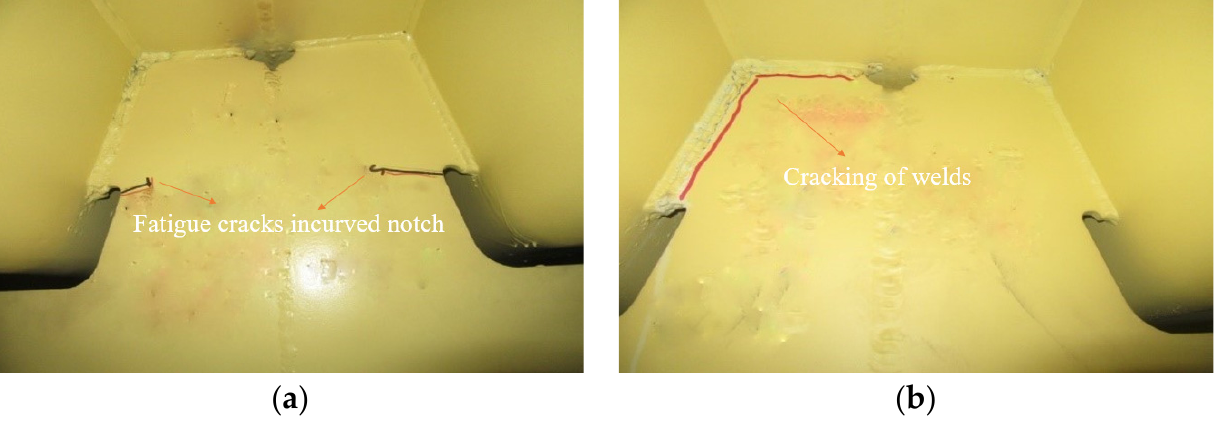
Figure 2. Fatigue cracking diagram of steel box beam (unit: mm): ( a ) The location of the cracking of the mother material in the curved cut of the cross partition, ( b ) welding defects between the horizontal spacer and U-rib panel.